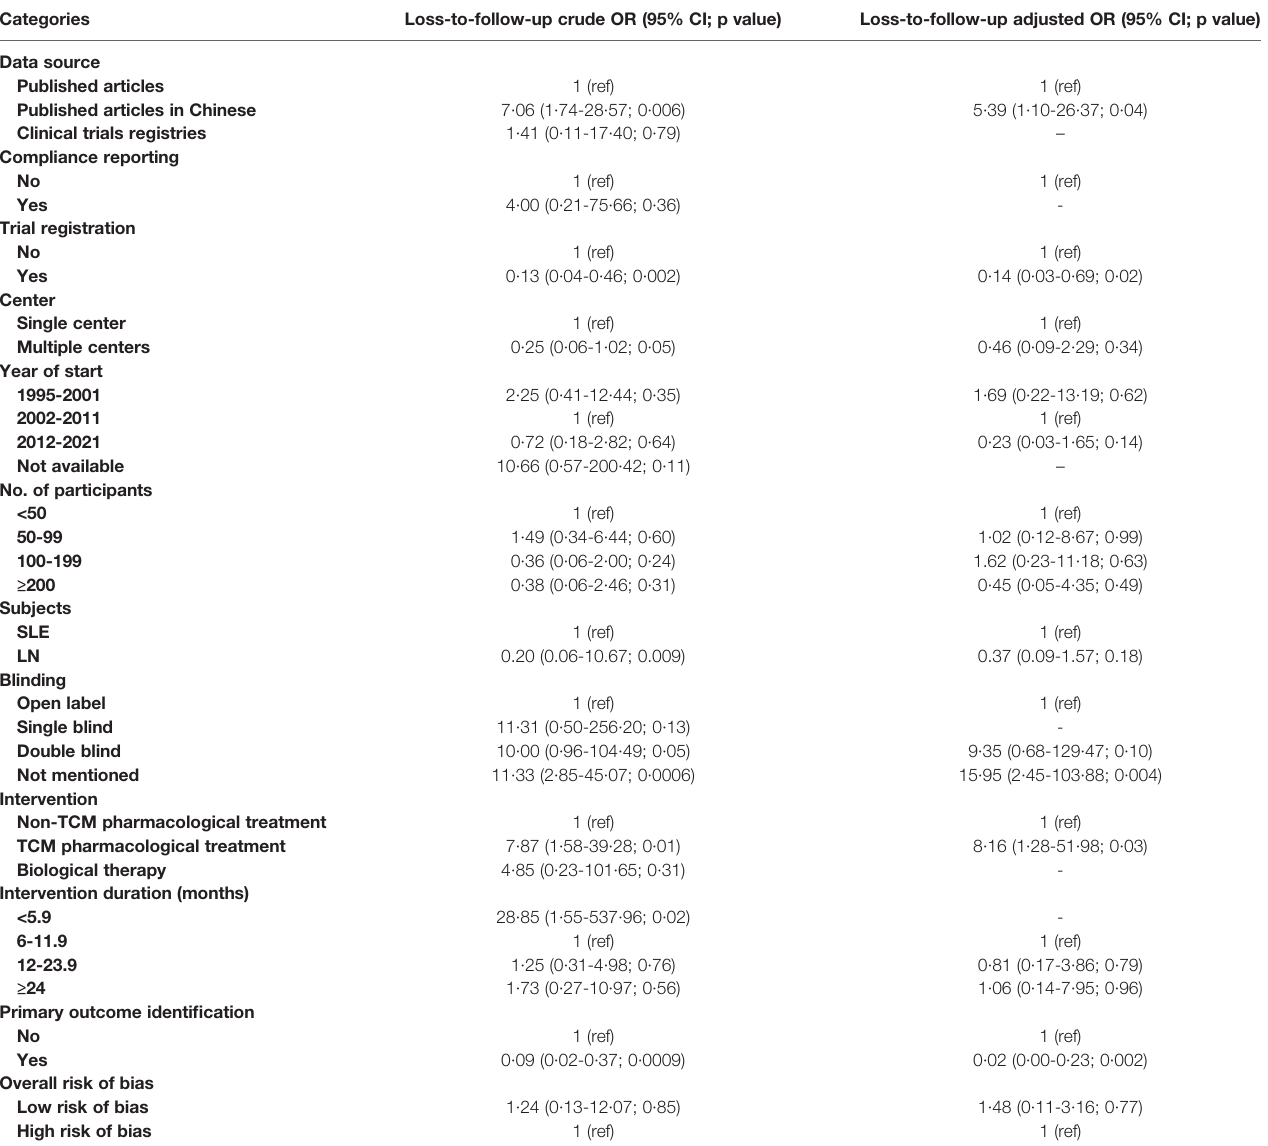
TABLE 1 | Crude and adjusted ORs for factors associated with less than 10% participant loss in single-country studies conducted in mainland